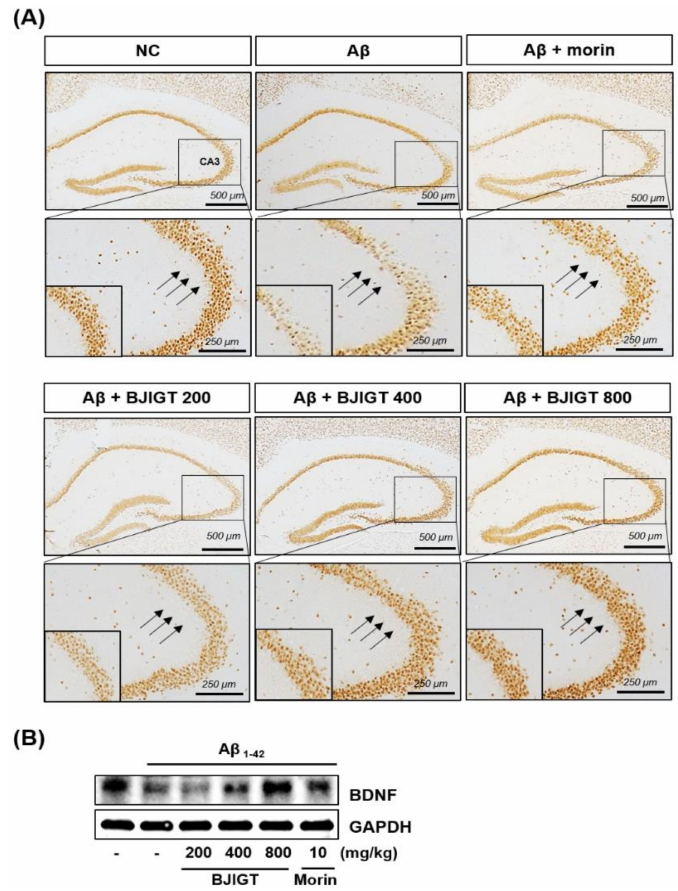
Figure 4. The effect of BJIGT on expression of neuronal marker NeuN and neurotrophic growth factor (brain-derived neurotrophic factor; BDNF) in an A β -induced AD mouse model. ( A )